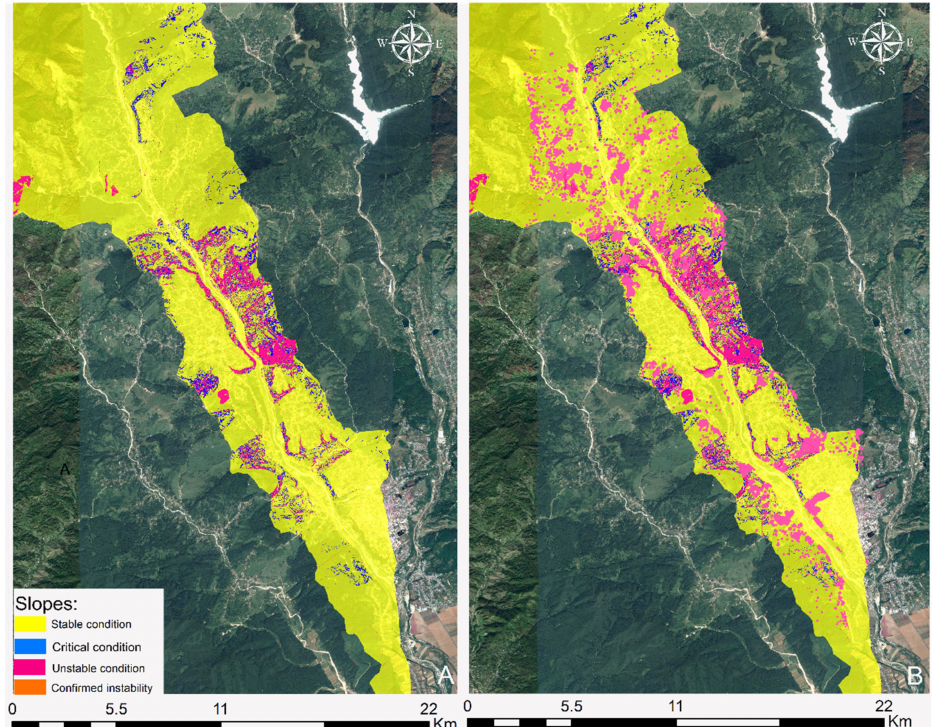
Figure 10. The susceptibility map ( A ) and the updated susceptibility map ( B ). The areas defined as stable, quasi-unstable or unstable in the deterministic map were updated to a confirmed instability class, if InSAR techniques detected corresponding active movement. Map created in QGIS3 software Base map: Landsat 8 scene from 20 August 2019, downloaded from Earth Resources Observation and Science (EROS) Center,